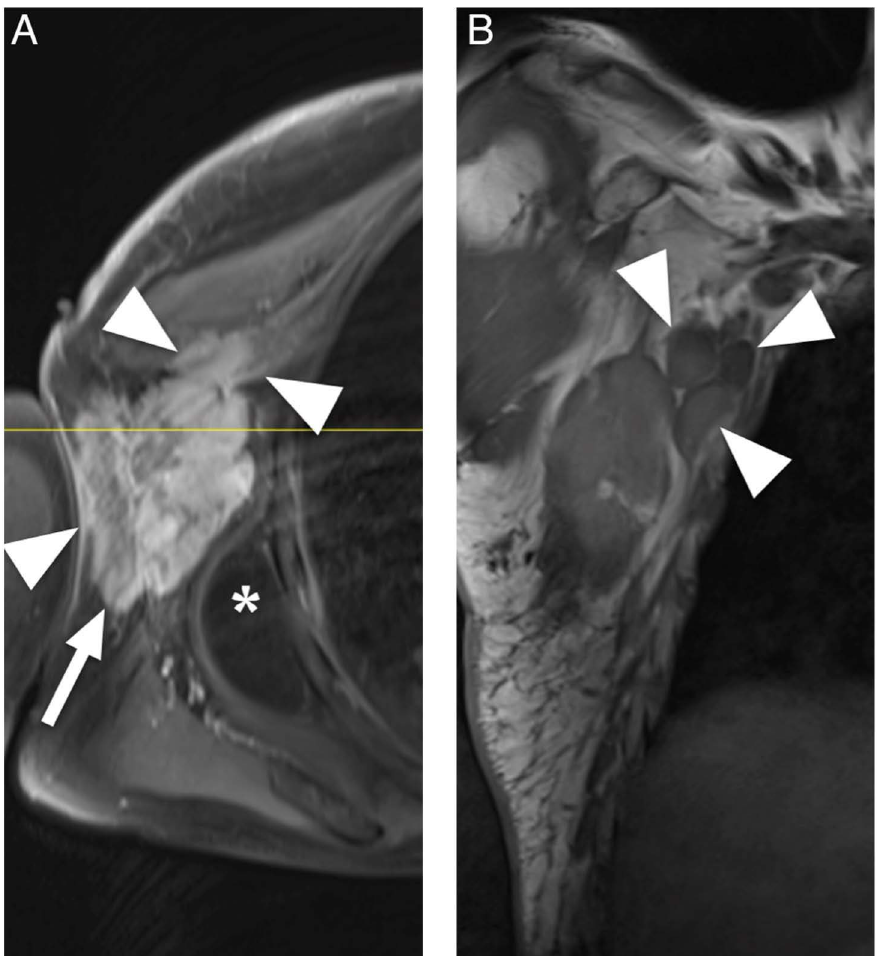
Figure 4. MRI of a 67-year-old man presenting with a predominantly subcutaneous manifestation of non-Hodgkin lymphoma in the right axilla. ( A ). Transversal contrast enhanced fat-saturated T1-weighted image shows a lobulated tumor (arrow) with inhomogeneous enhancement pattern which infiltrates into the pectoralis major and minor muscles and skin (arrowheads). Moreover, an accompanying lipoma can be noted (asterisk). ( B ). Coronal T1-weighted image shows associated lymphadenopathy (arrowheads).